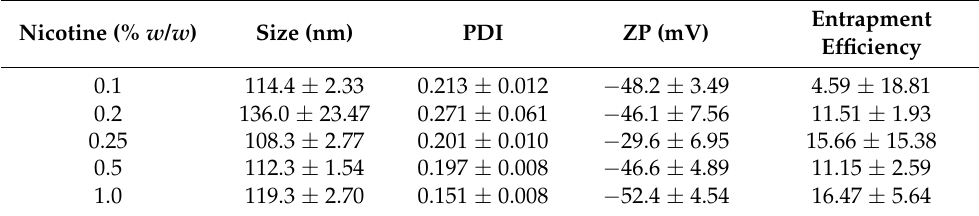
Table 2. Size, PDI, ZP, and percent entrapment efficiency of SLNs loaded with different concentrations of nicotine ( n = 3).